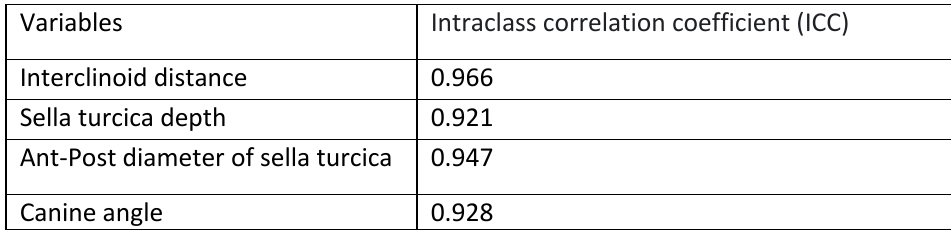
Table 2: Method Error According to Intraclass correlation